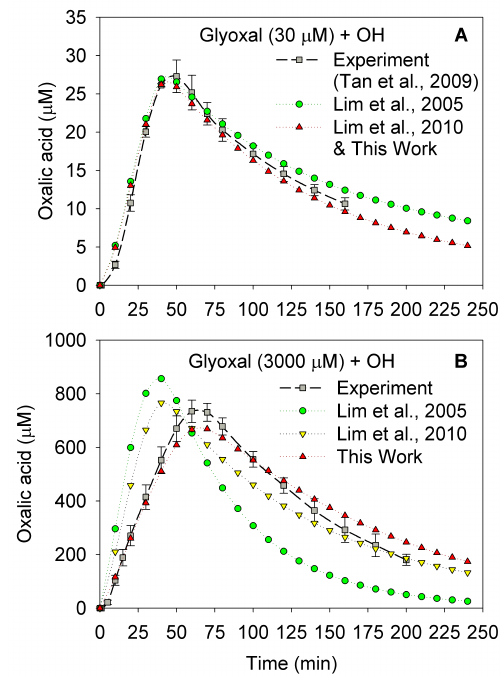
Fig. 6. Real-time profiles of oxalic acid produced from OH radical oxidation of glyoxal at initial concentrations of 30µM (A) and 3000 µM (B) ; experimental results (Tan et al., 2009) and previous/current model simulations (using the model of Lim et al., 2005, 2010; this work).